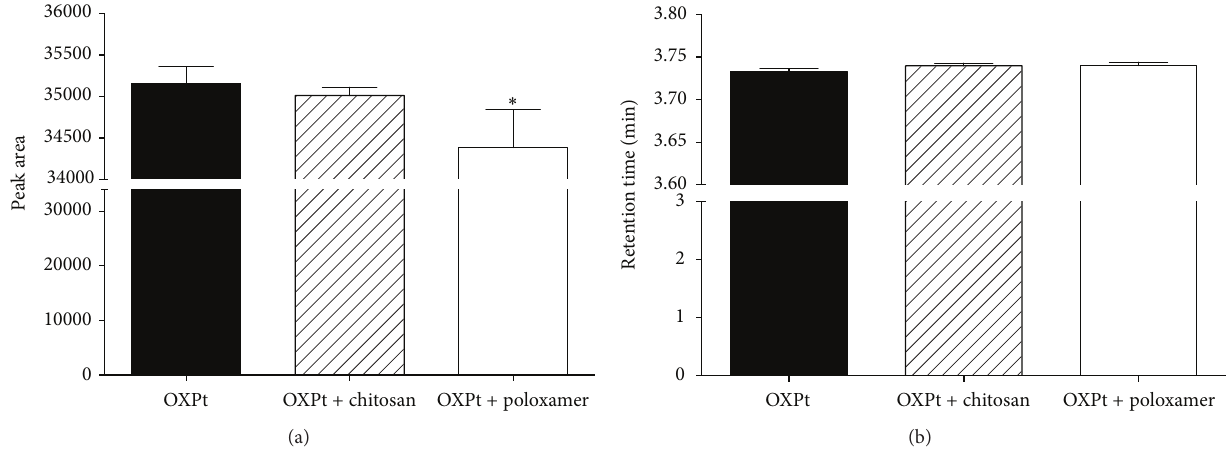
Figure 4: Selectivity of the method in quantification of OXPt (5.0 𝜇 g/mL), alone, with poloxamer (5.0 𝜇 g/mL), or with chitosan (5.0 𝜇 g/mL), analyzed in terms of differences in (a) peak areas and (b) retention times. ∗ 𝑝 < 0.05 .